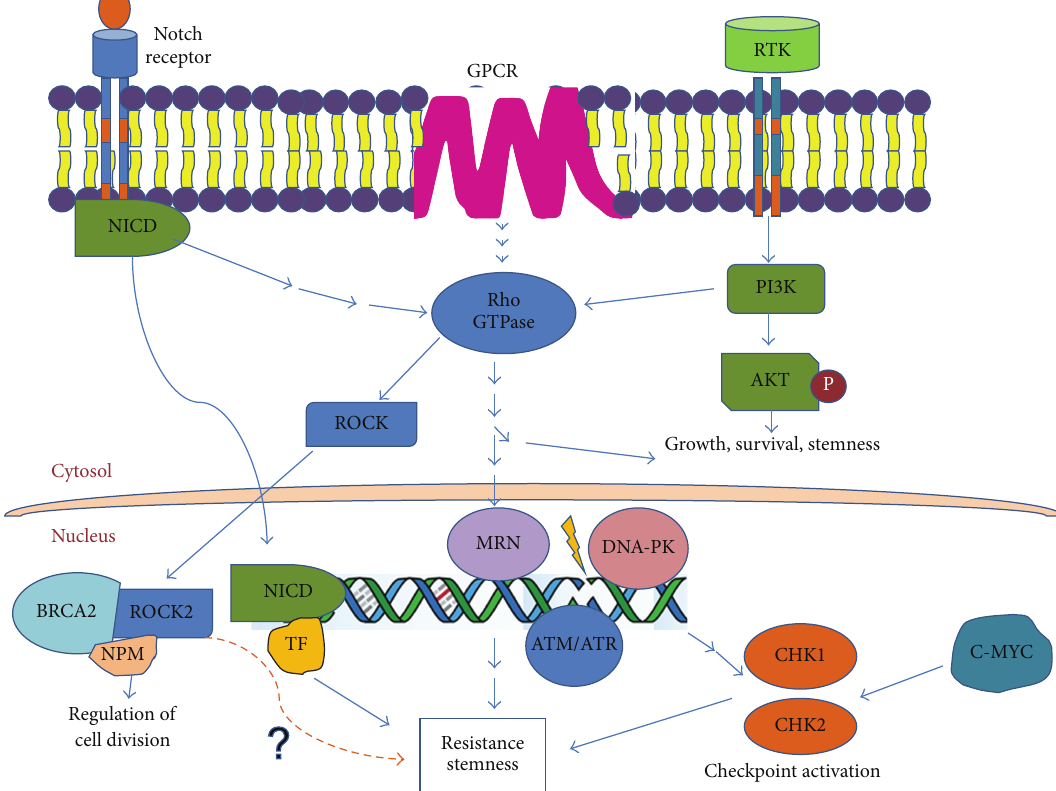
Figure 1: Cross talk between multiple signaling pathways involved in tumor progression and